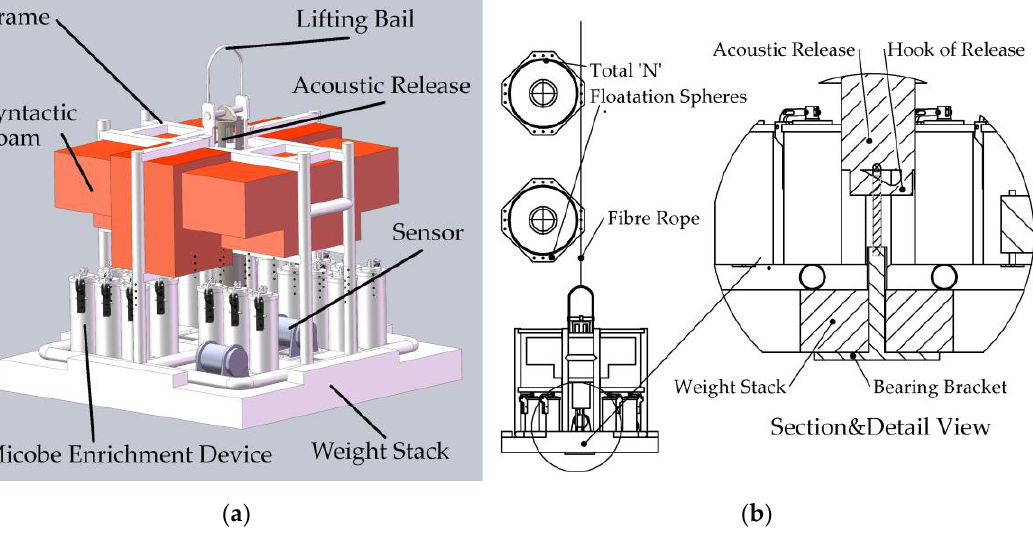
Figure 1. ( a ) The overall structure of the benthic lander; ( b ) the working principle of the benthic lander.